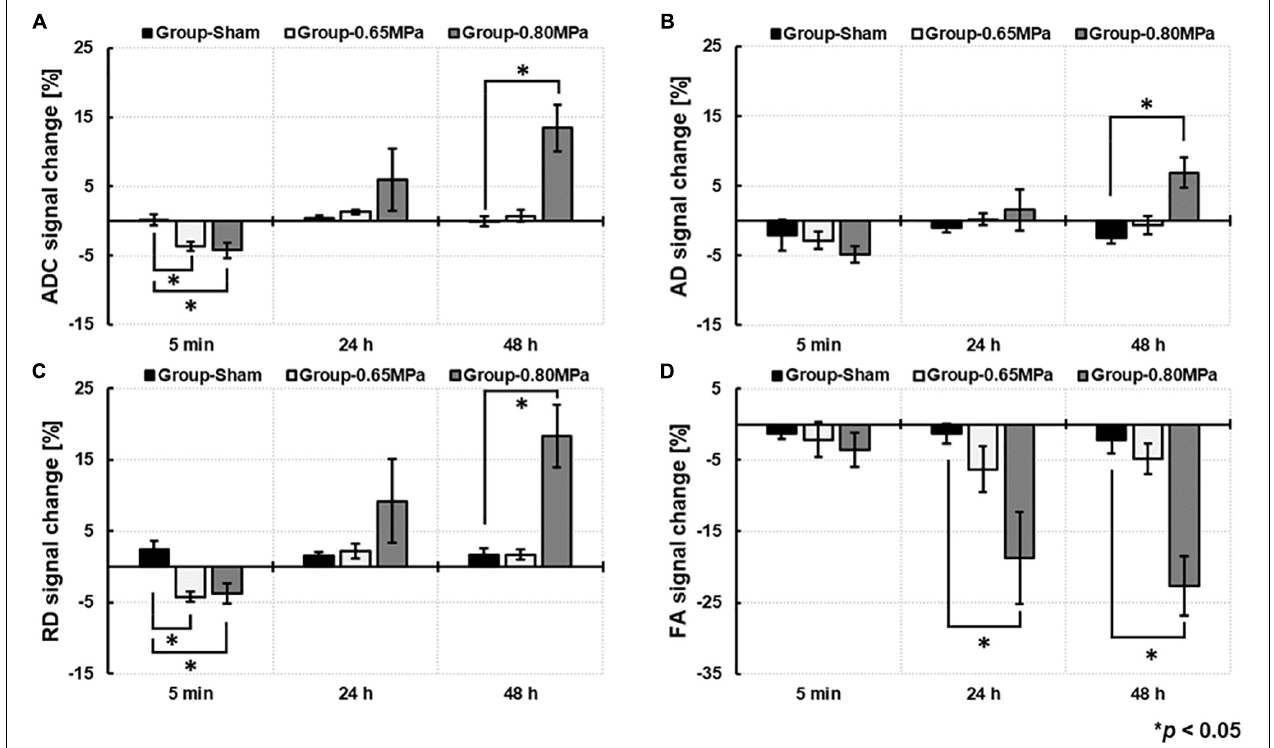
FIGURE 4 | Comparison of DTI measures of (A) ADC, (B) , AD, (C) RD, and (D) FA based on the signal change ratio between group-sham, group-0.65 MPa, and group-0.80 MPa after 5 min, 24 and 48 h of the FUS–BBBD. ∗ p <